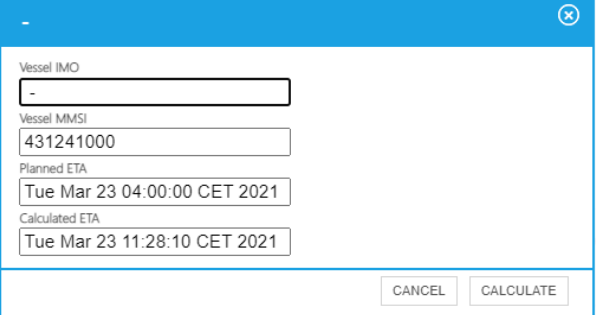
Figure 6. Predicted